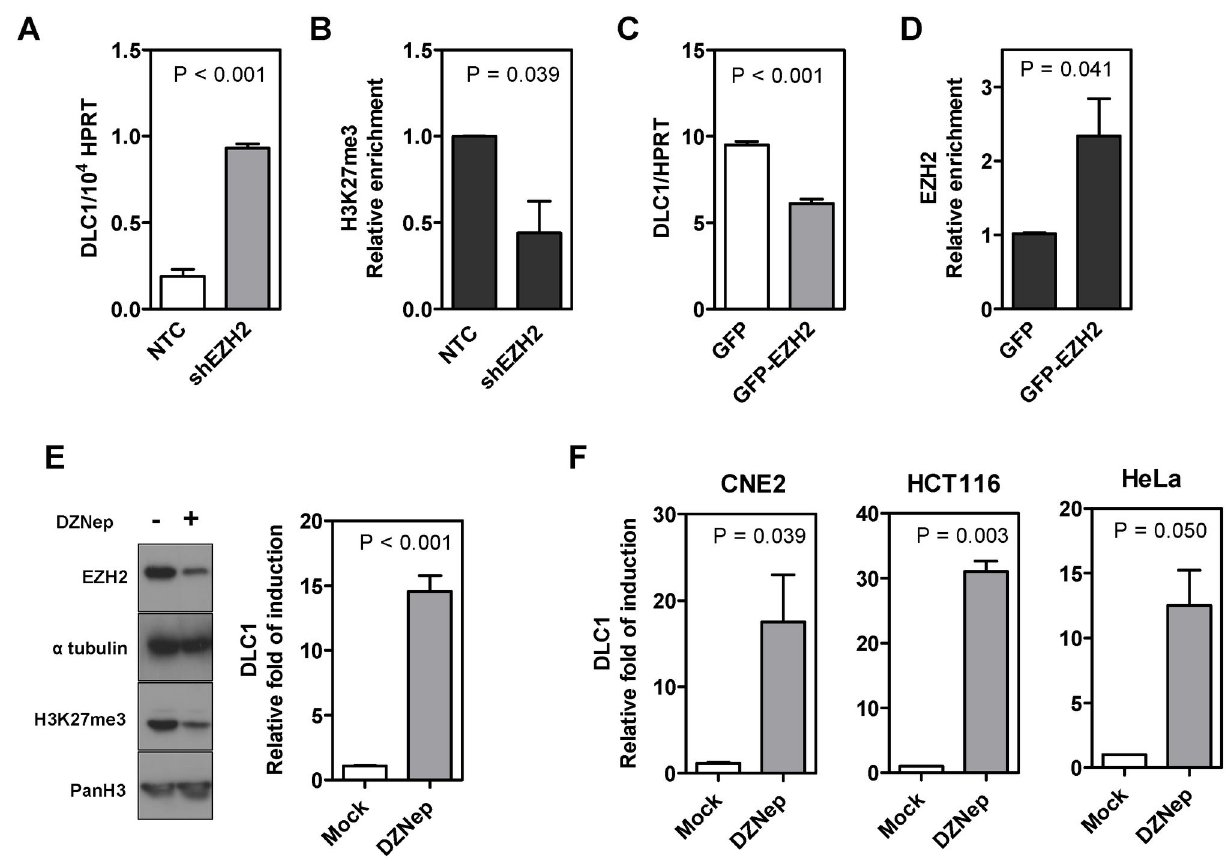
Figure 2. EZH2-mediated H3K27me3 was involved in epigenetic repression of DLC1 in HCC and multiple other human